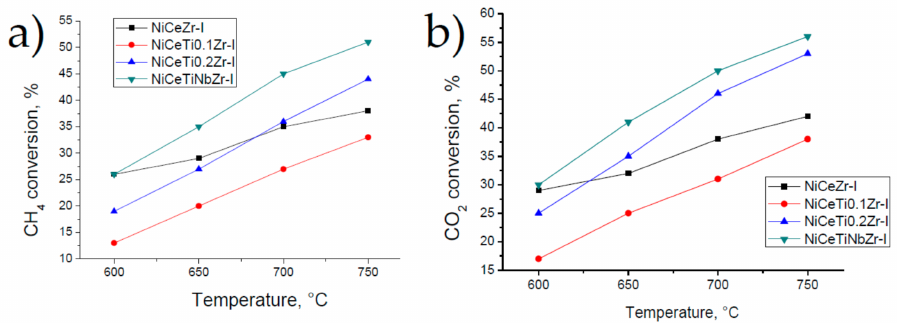
Figure 6. The dependences of ( a ) CH 4 conversion and ( b ) CO 2 conversion on temperature for